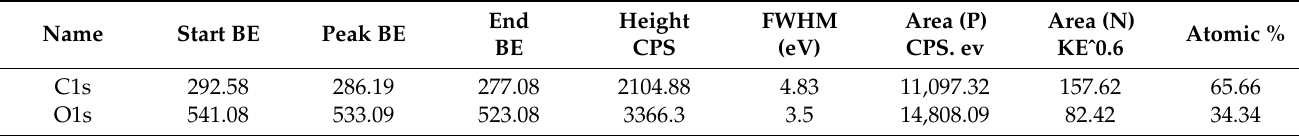
Table 2. Peak table of untreated cotton